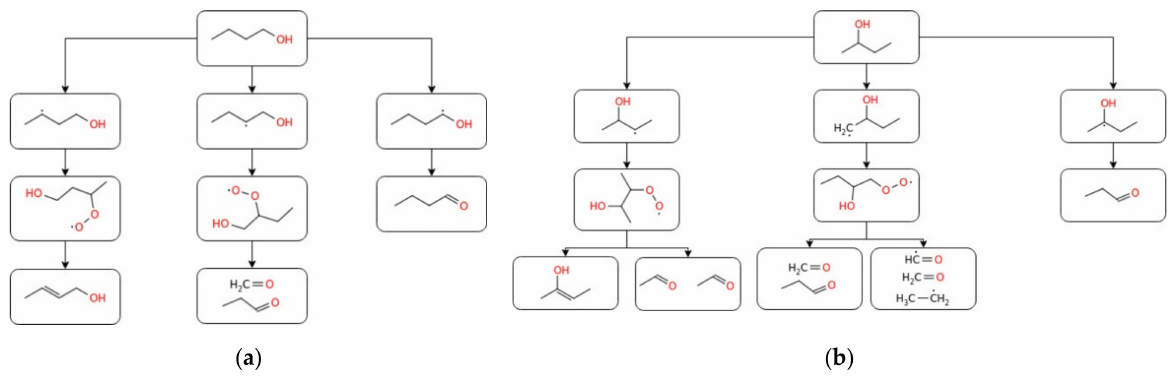
Figure 8. A simplified reaction pathway for 1-butanol ( a ) and 2-butanol ( b ) oxidation.